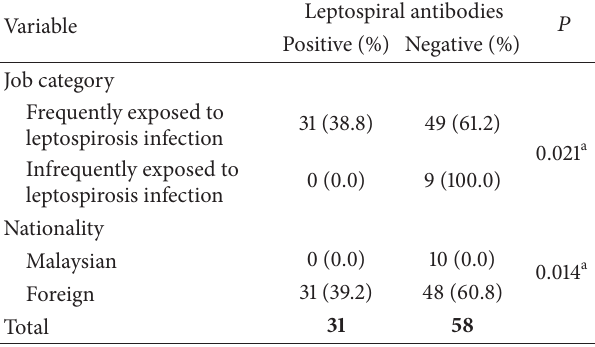
Table 5: Association between seropositivity of leptospiral anti- bodies with job category and nationality among municipal service